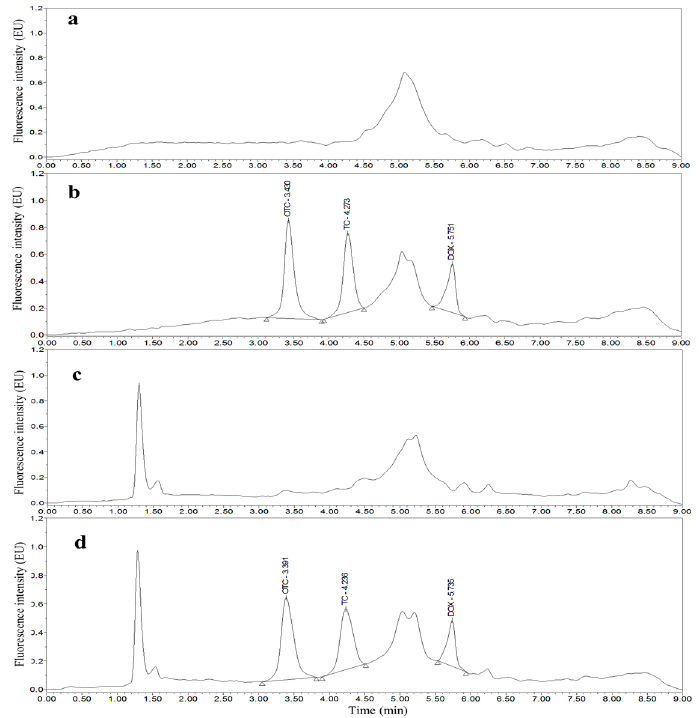
Figure 4. Chromatograms of the mobile phase ( a ), 50 μ g/kg CIP and 25 μ g/kg ENR standards ( b ), blank chicken albumen ( c ) and blank chicken albumen spiked with 50 μ g/kg CIP and 25 μ g/kg ENR standards ( d ) from channel B.